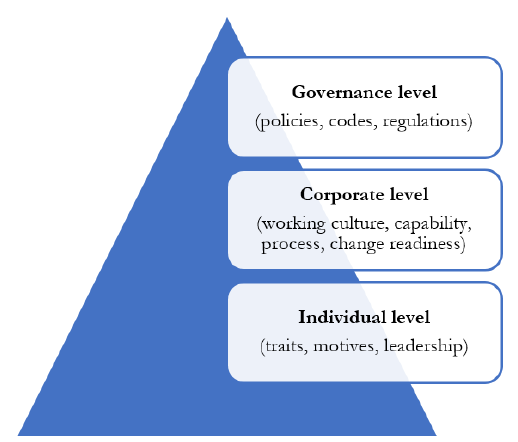
Figure 4. Level of the influence of “people” over success or failure of adopting and implementing lean construction.